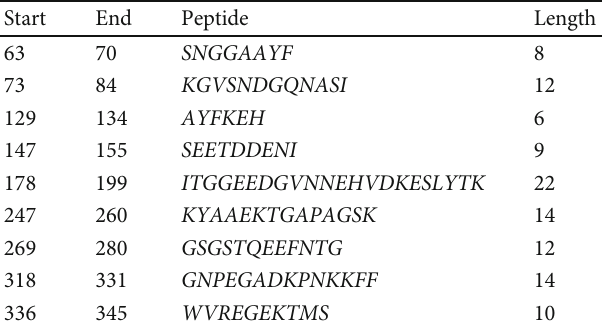
Figure 4: Kolaskar and Tongaonkar antigenicity prediction test: the red line is the threshold; above (the yellow part) is proposed to be part of the B-cell epitope. Table 1: The proposed predicted antigenic B-cell epitopes; 9 antigenic sites were identi fi ed from fructose bisphosphate aldolase of C. glabrata .